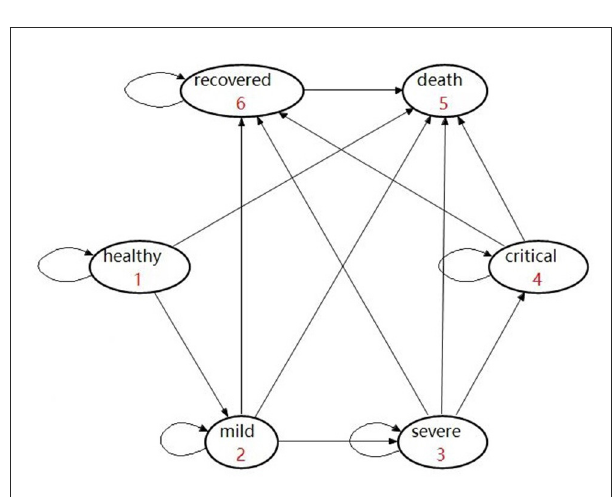
FIGURE3 Markov health states showing the “ineffectively vaccinated” and “not vaccinated” arms.